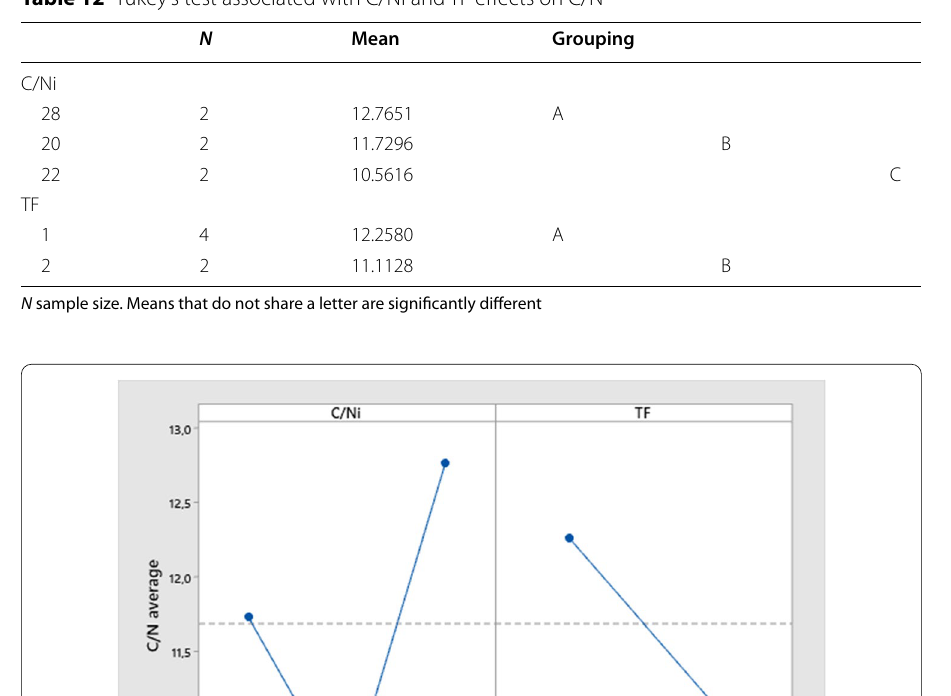
Table 12 Tukey’s test associated with C/Ni and TF effects on C/N